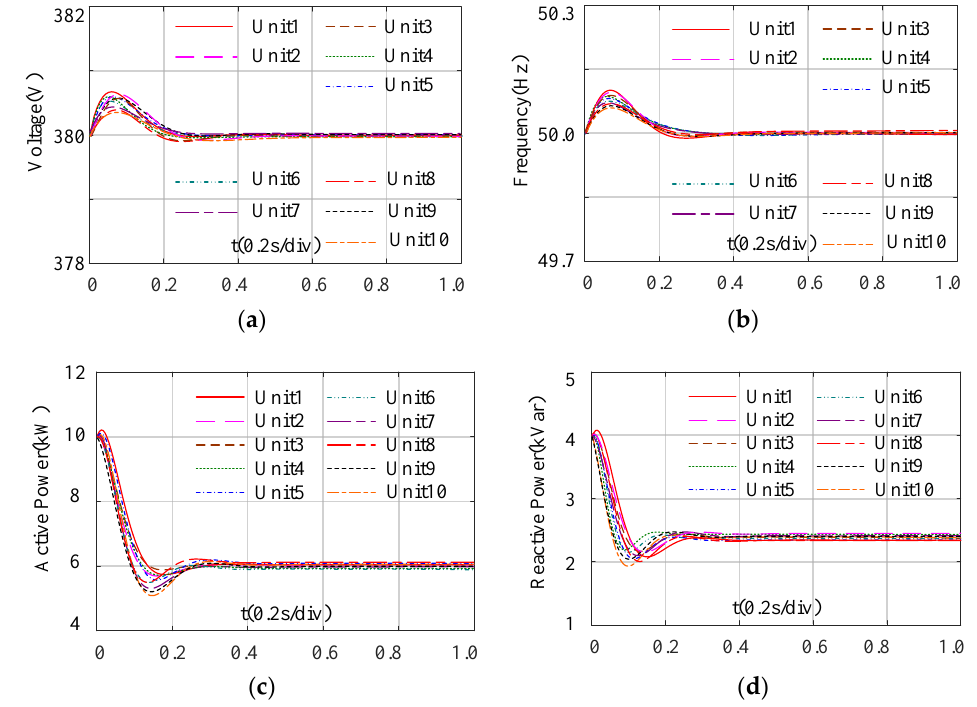
Figure 12. The simulation waveforms with the proposed control strategy under load change at t = 0 s. ( a )voltage amplitude;( b ) frequency;( c ) active power;( d ) reactive power. s. ( a ) voltage amplitude; ( b ) frequency; ( c ) active power; ( d ) reactive